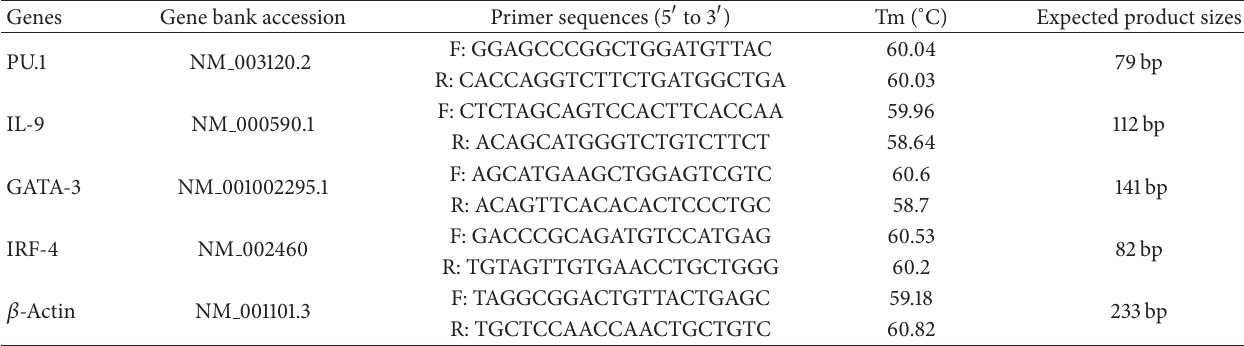
Table 2: Primers and cycling parameters for real time RT-PCR detection of PU.1 and